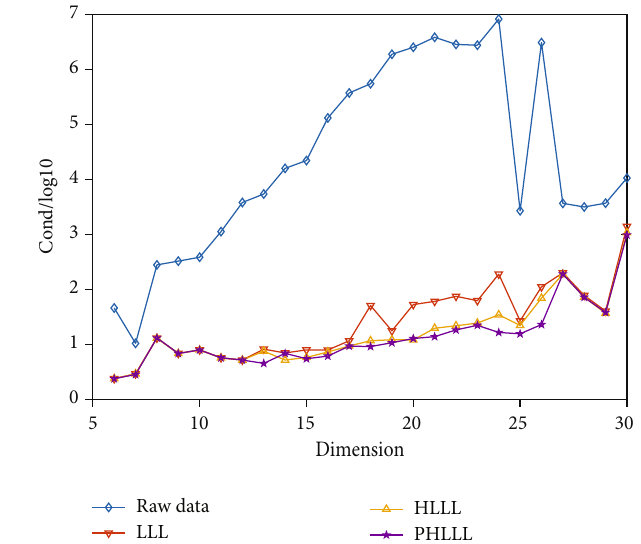
Figure 1: Comparison chart of condition numbers in four